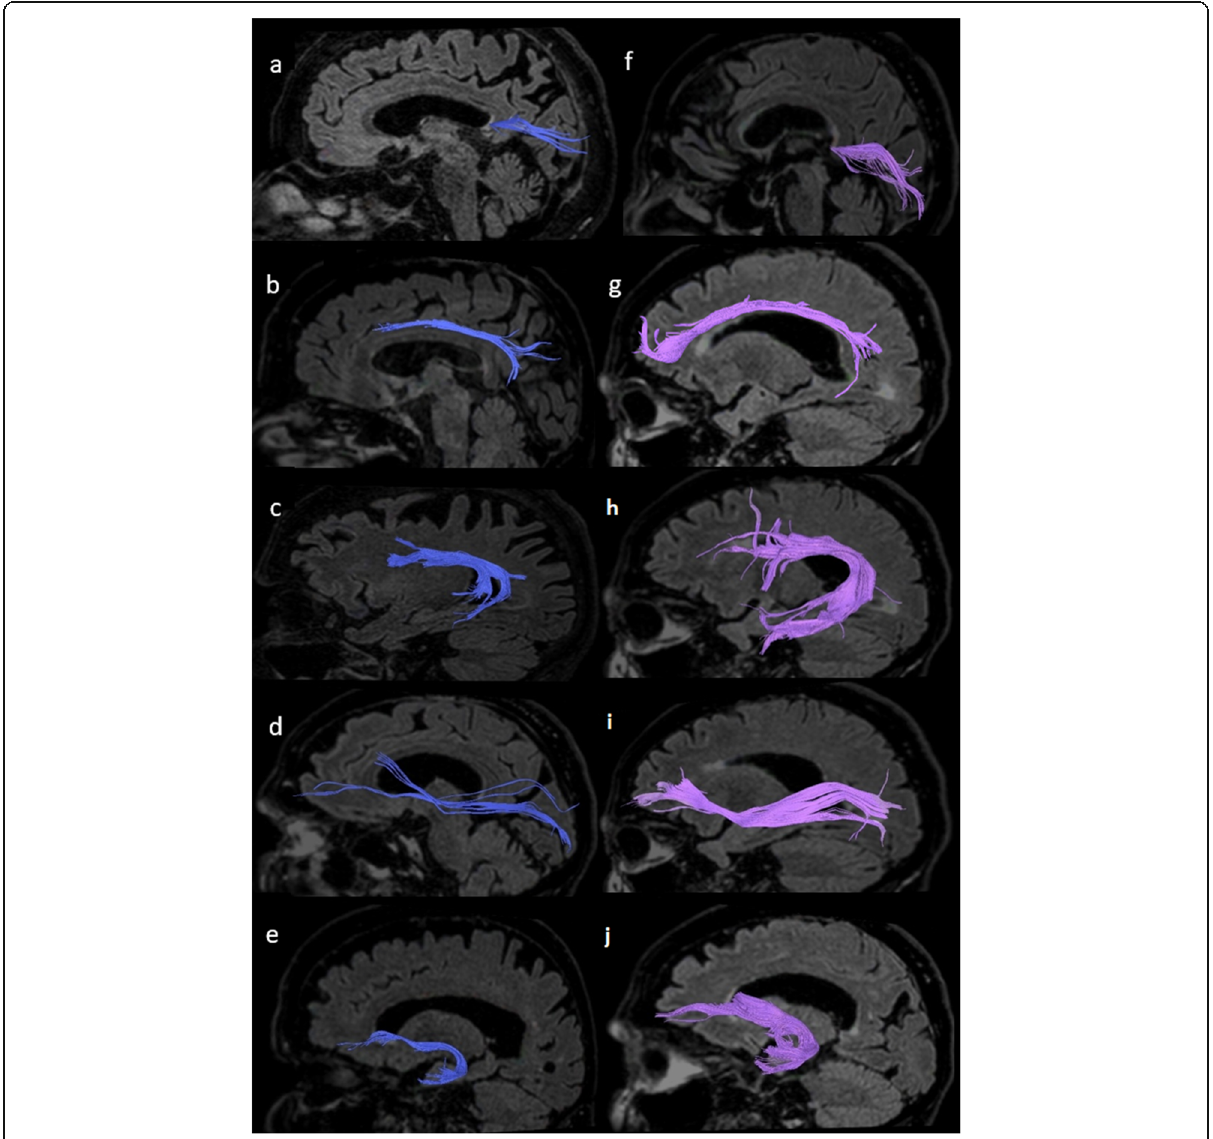
weighted images. White matter tracts of AD patients ( a – e ) are shown in blue color; while white matter tracts of the healthy subjects ( f – j ) are shown in purple color. a , f Splenium. b , g Cingulum. c , h Arcuate fasciculus. d , i Inferior fronto-occipital fasciculus. e , j Uncinate fasciculus.